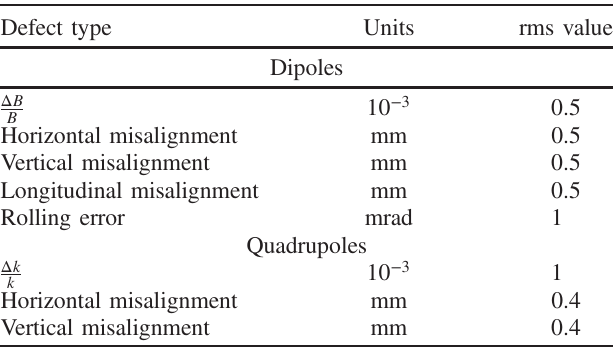
TABLE XI. Assumed tolerances for magnetic elements.